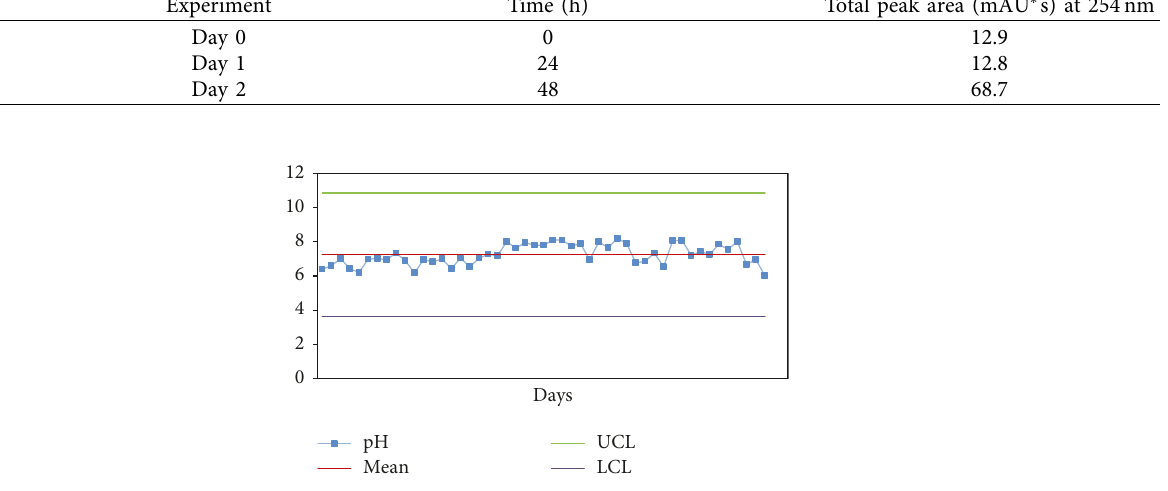
Figure 4: Control chart (six-sigma limits) indicating the trend of pH of lab water (18.2M Ω × cm at 25 ° C) over time ( n � 49 days/year). UCL: upper control limit; LCL: lower control limit.